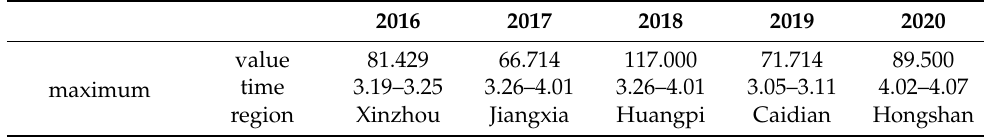
Table 8. O 3 maximum/minimum statistics from 2016 to